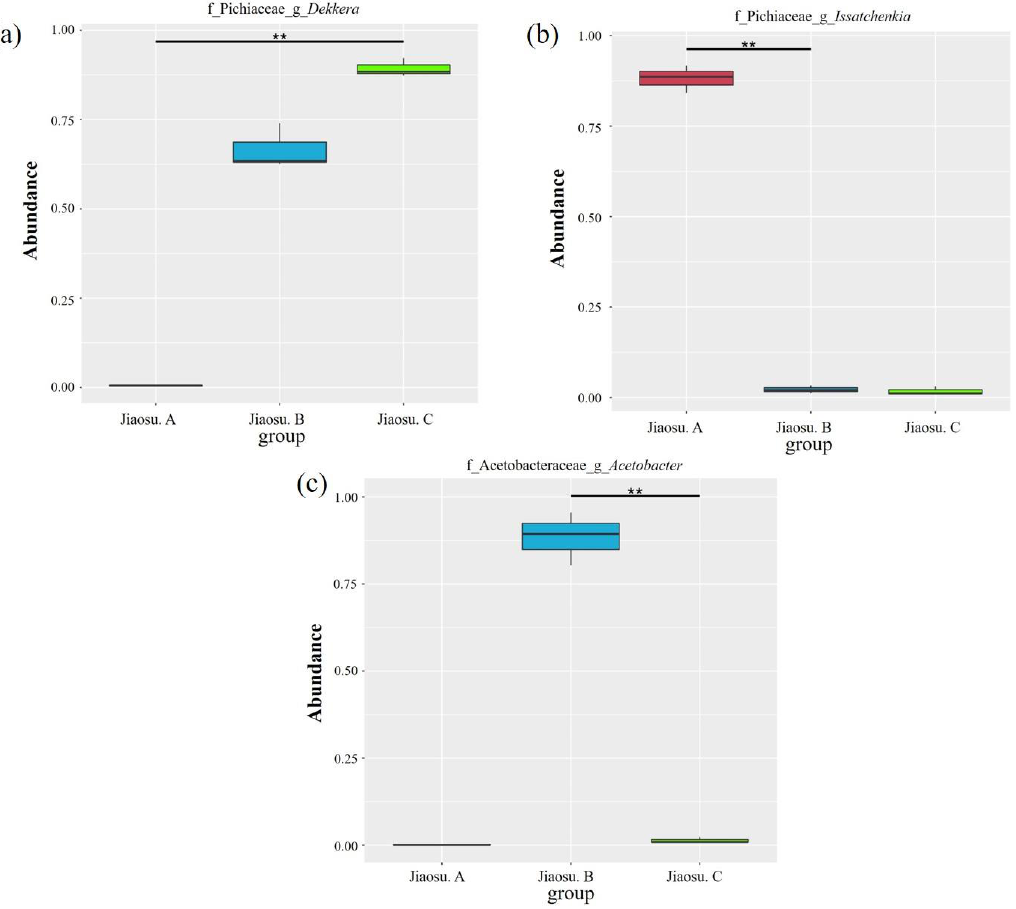
Figure 4. Diagrams of the distribution boxes of fungi ( a , b ) and bacteria ( c ) at the genus level. Note: “f”, family; “g”, genus; “**” indicates significant differences between groups ( p < 0.01).